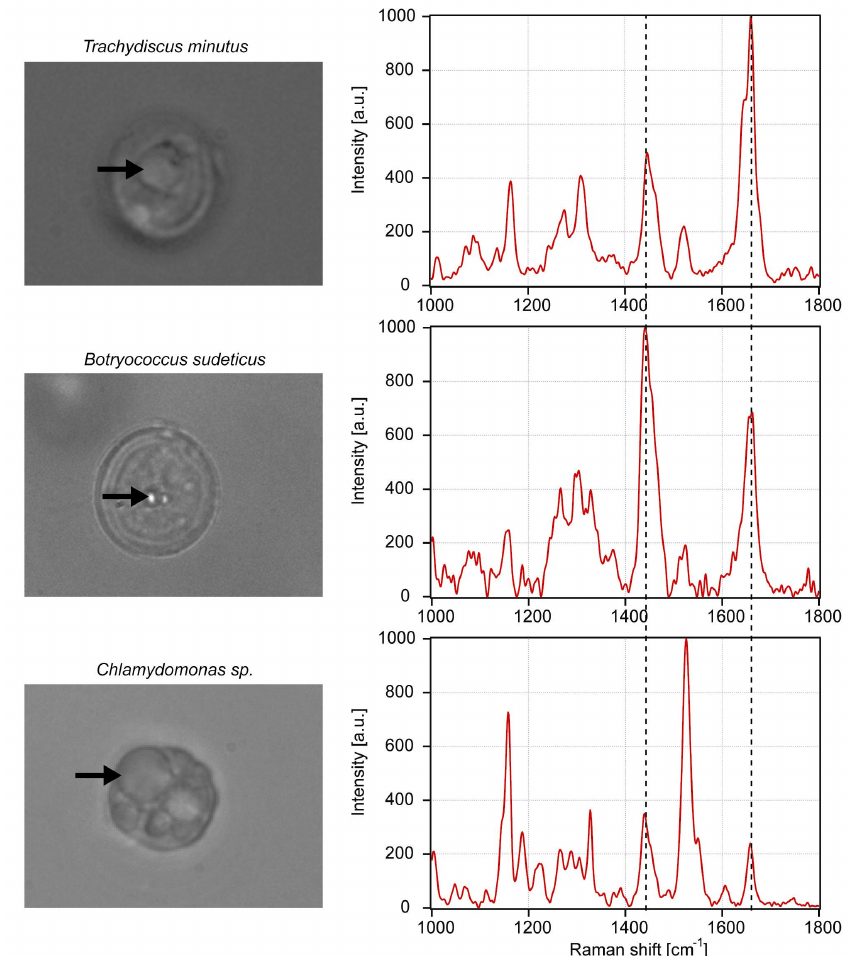
Figure 6. Typical Raman scattering spectra of intracellular lipid bodies contained in three different algal species: Trachydiscus minutus (top), Botryoccocus sudeticus (middle), and Chlamydomonas sp (bottom). Raman bands used for the calculations of iodine value are highlighted with dashed vertical lines. Corresponding pictures to the left of the spectra show the lipid bodies from which the spectra were recorded (indicated by the black